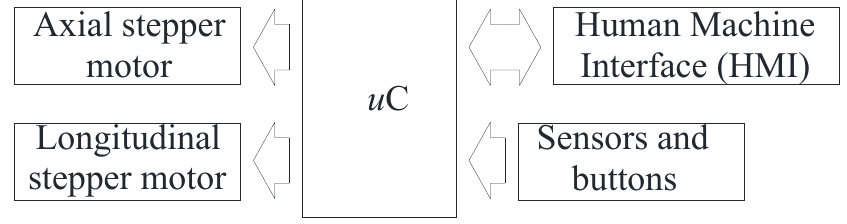
Figure 9. Electronic circuit block diagram.